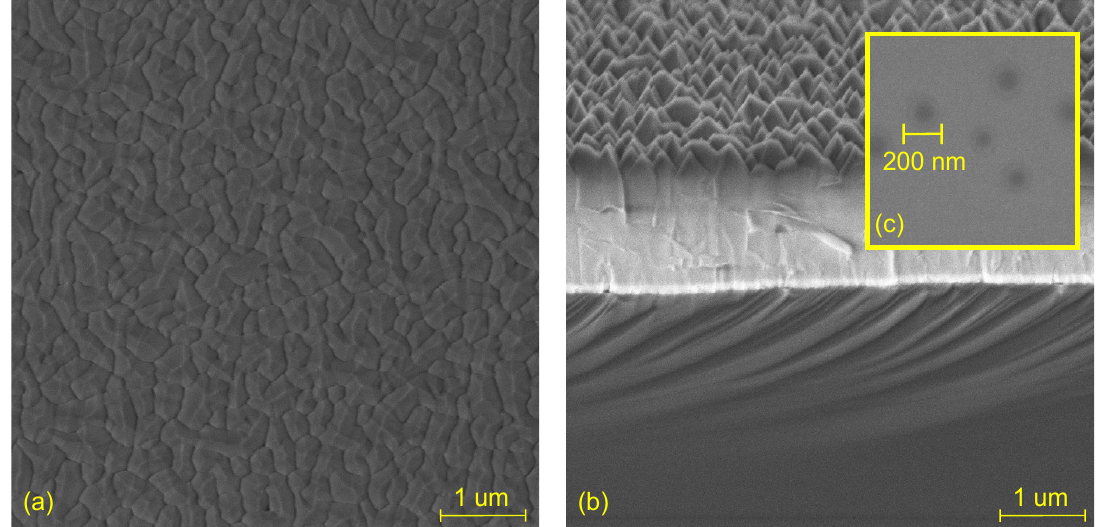
Figure 4. Top ( a ) and cross-sectional ( b ) SEM images of regrown AlN layer by MOCVD on top of ALD AlN transition layer (TL); ( c ) Top SEM image of blisters in the TL AlN grown on Si<100> with an in situ ALA treatment at plasma power of 100W and